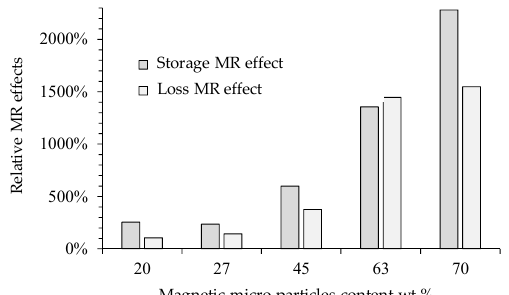
Figure 17. The maximum relative MR effects achieved in the storage and loss moduli for different MRE samples. The MR effects for the storage and loss moduli were computed when a magnetic flux density of 1093 mT was applied with respect to those values obtained when the material samples were subjected to rheology tests without the application of a magnetic flux density.